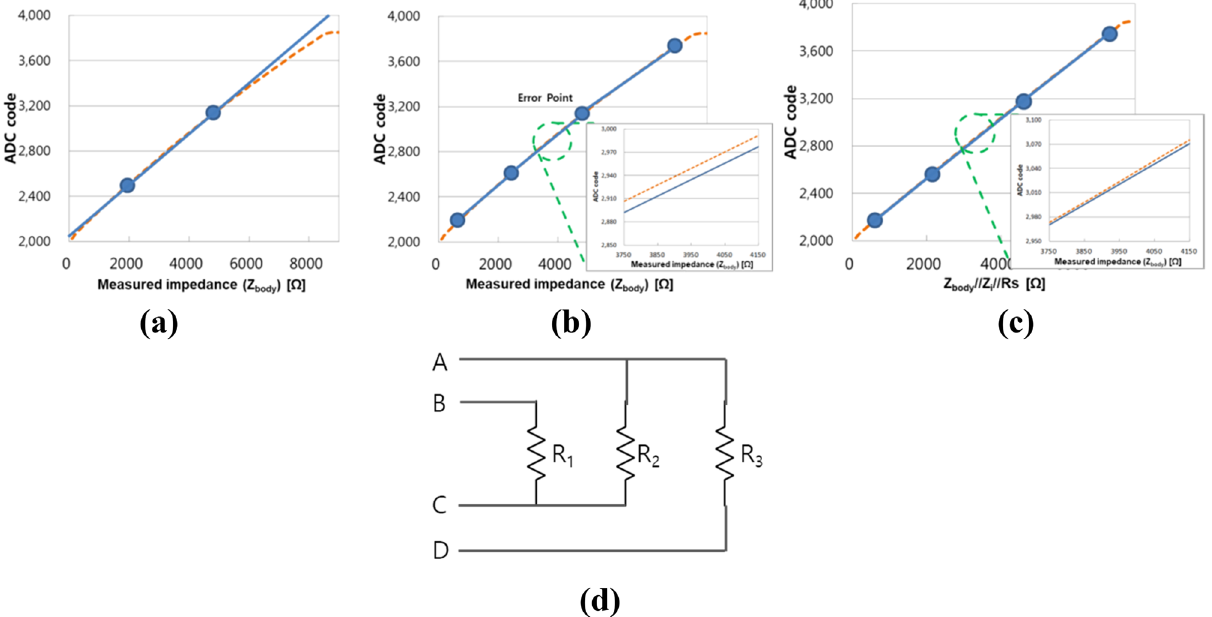
Figure 5. Calibration curve and measurement error at midpoint between two reference points for ( a ) 2-point calibration, ( b ) 4-point calibration, and ( c ) 4-point coordinate conversion calibration. ( d ) Calibration circuit for 4 reference resistance values (A ‒ C route: R 2 , A ‒ D route: R 3 , B ‒ C route: R 1 , B ‒ D route: R 1 + R 2 + R 3 ). ADC analog-to-digital converter, Z i input impedance of the voltmeter, R s output impedance of the current